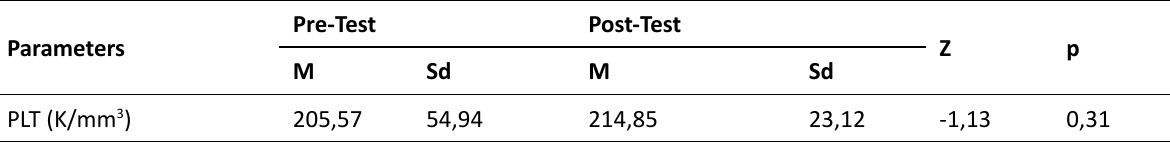
Table 4. Comparison of for the pre- and post-tests of platelet mean